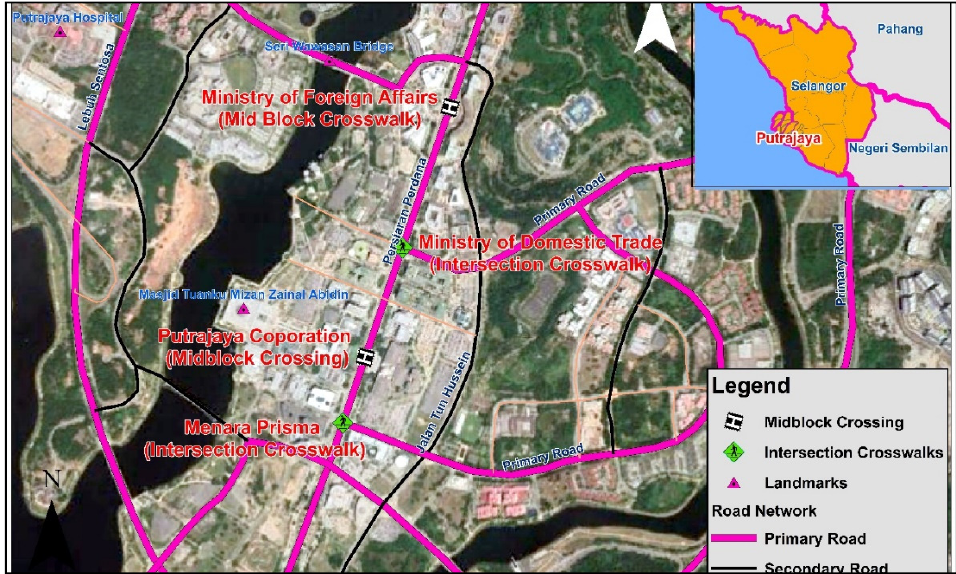
Figure 1. The study area map (Source: Google Earth).